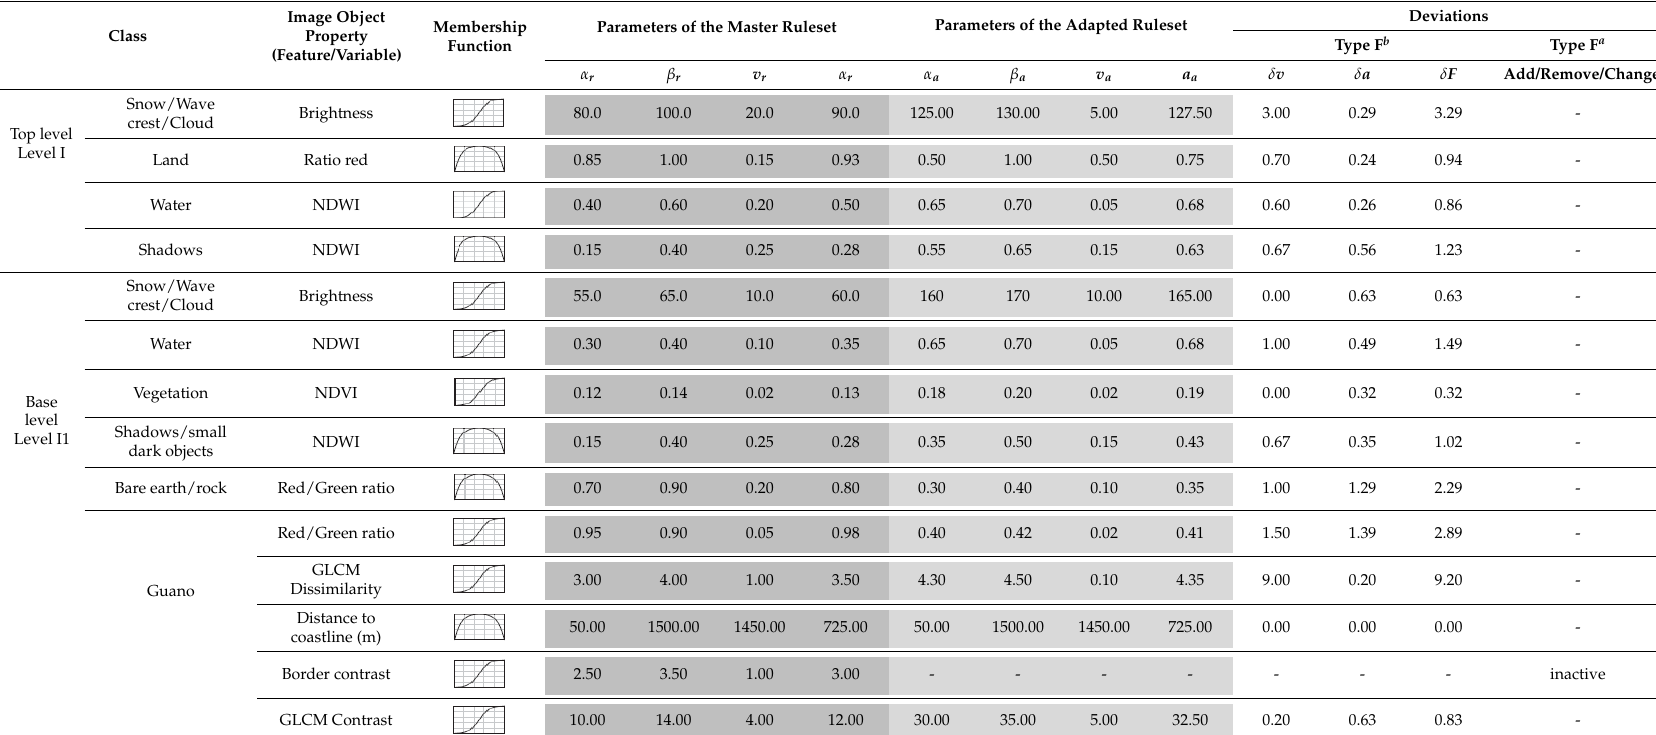
Table 9. Ruleset adaptation from HOPE to ZAVO.